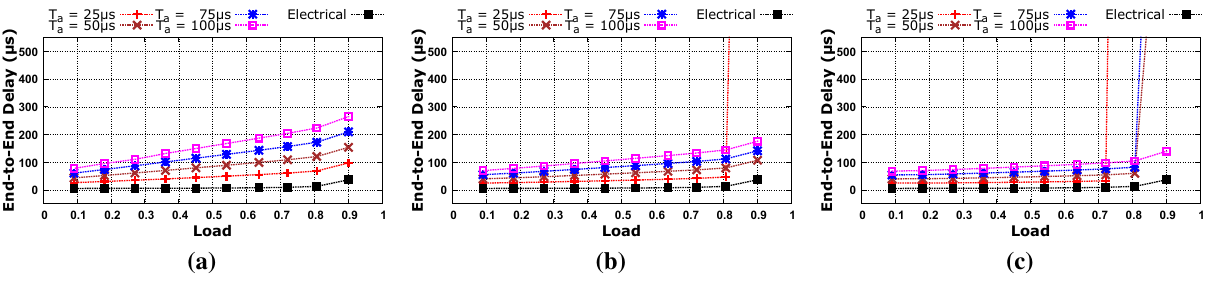
Figure 5. Average end-to-end latency with different parameters of traffic aggregation and with respect to different network over-subscription for high diversity traffic, i.e. , TDC = 10. ( a ) Fully Subscribed Network; ( b ) 2:1 Over-subscribed Network; ( c ) 4:1 Over-subscribed